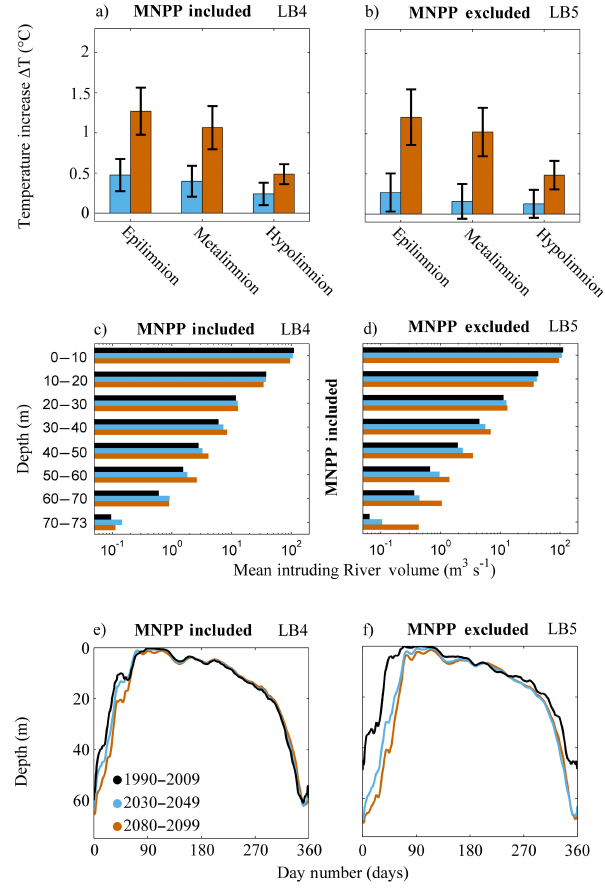
Figure B1. Modeled climate impact on LB excluding river-borne SSC. Temperature increase (cid:49)T ( a and b ) displayed as means (bars) and standard deviations (black lines) in epilimnion (left bar group), metalimnion (middle bar group) and hypolimnion (right bar group); mean intruding river volume ( c and d ) and mean river intrusion depth ( e and f ). MNPP thermal input included (a, c, e) or ex- cluded (b, d, f) in near-future (blue) and far-future (vermilion) time periods but retained in the reference period (black).